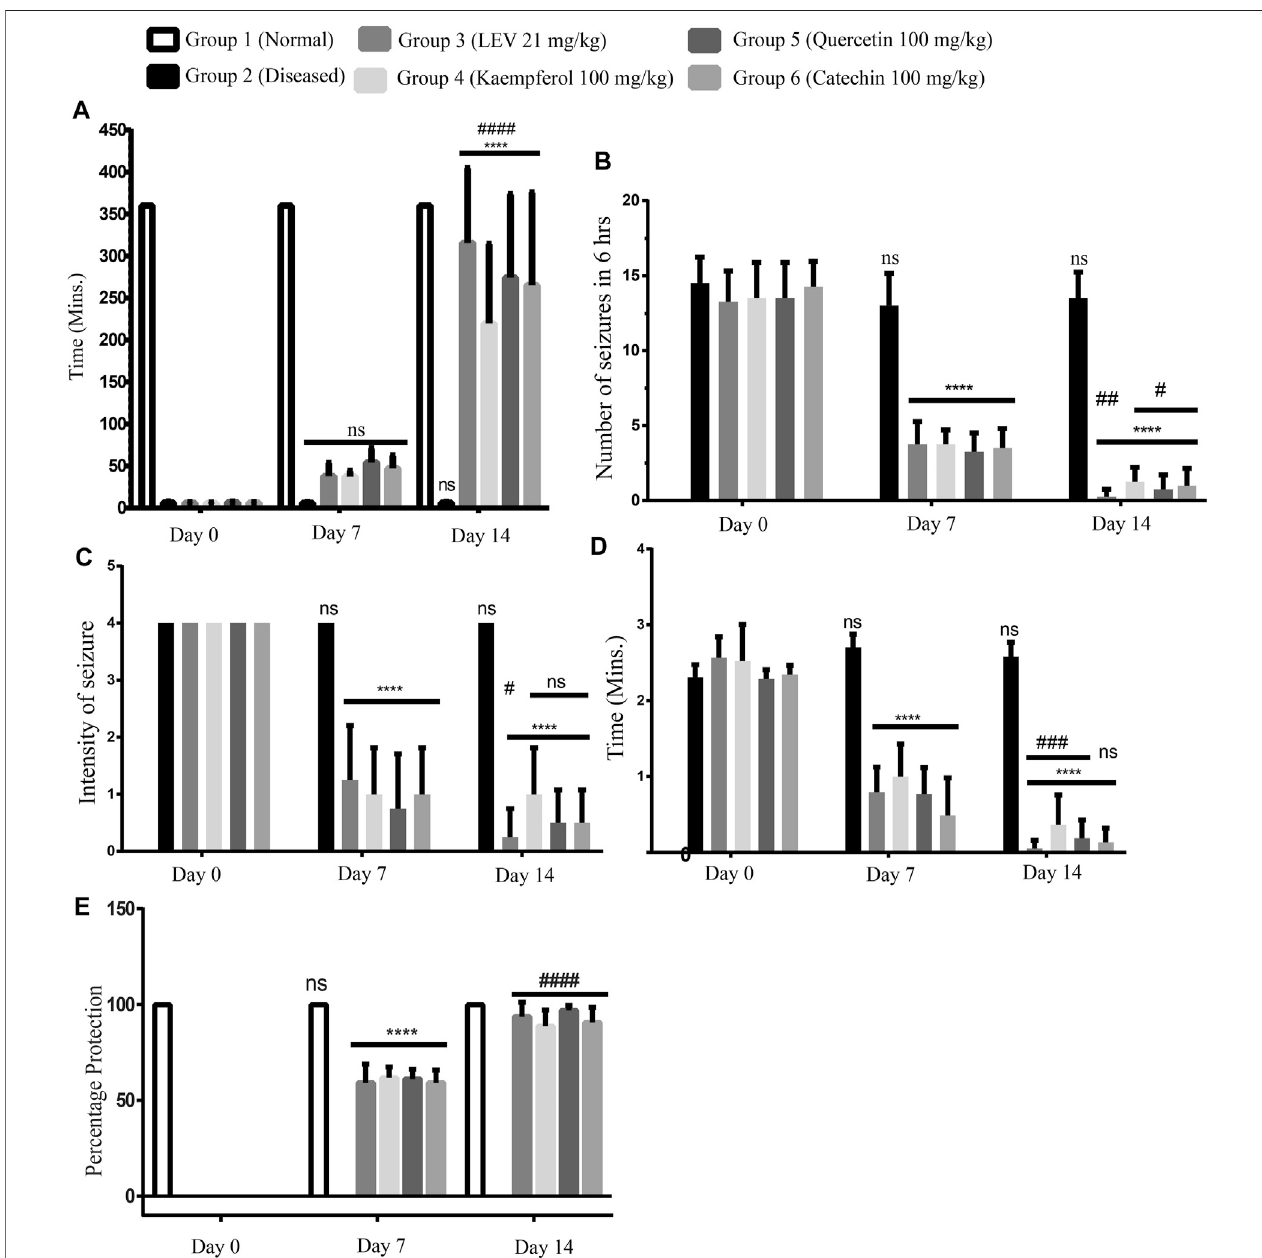
FIGURE 3 | (A) Delay in the onset of seizures, Day 0: onset of seizures was less than a minute after induction. At Days 7 and 14 of treatment, onset was delayed in each groupup to60 min and/or upto 360 min (maximum time), respectively. ANOVA, F(5/42) (cid:2) 15.68, con fi rmedsigni fi cantimprovement at Day 14amongthe groups and also between two time points. While at time points Day 7 and Day 14, there was no signi fi cant difference among standard treatment and phyto fl avonoid-treated groups. (B) Number of seizures, Day 0: number of seizures in all the rats was more than 13; at Day 7 of treatment in the treatment group, there was a signi fi cant reductioninthenumberofseizures.OnDay14,thenumberofseizureswassigni fi cantlyreducedascomparedtobothDay0andDay7until360 min(6 h).ANOVA,F(5/ 42) (cid:2) 88.26, con fi rmed signi fi cance improvement at day 14 among the groups and also between two time points. (C) Intensity of seizures, Day 0: Intensity of seizures in all the rats was more than 3; at Day 7 of treatment in the treatment group, there was a signi fi cant reduction in the intensity of seizures; at Day 14, the intensity of seizures was signi fi cantly reduced as compared to Days 0 and 7 until 360 min (6 h). ANOVA, F (5/42) (cid:2) 16.25, con fi rmed signi fi cant improvement at Day 14 among the groups and also between two time points. (D) Average duration of seizures, Day 0: Average duration of seizures in all the rats was more than 2 min per seizure; at Day 7 of treatment in the treatment group, there was a signi fi cant reduction in the duration of seizures; at Day 14, the duration of seizures was signi fi cantly reduced as compared to Days 0 and 7 until 360 min (6 h). ANOVA, F (5/42) (cid:2) 139.4, con fi rmed signi fi cant improvement at Day 14 among the groups and also between two time points. (E) Percentage protection of seizure, Day 0: all the groups observed seizures except the normal group. At Days 7 and 14 of treatment, seizures were protected in all the groups, but no protection was observed in the diseased group during the observation time. ANOVA, F (5/42) (cid:2) 60.30, con fi rmed signi fi cant improvement at Day 14 amongthegroupsandalsobetweentwotimepoints.WhileattimepointsDay7andDay14,therewasasigni fi cantimprovementamongthestandardtreatmentandPF- treated groups. p < 0.0001. ** p < 0.05, *** p < 0.0005, and **** p < 0.0001 (Newman – Keuls multiple comparison post-test Day 0 vs Day 7 * and Day 7 vs Day 14#).